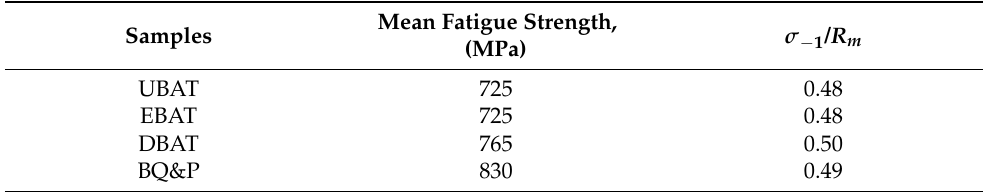
Figure 3. S-N data of steels treated by various melting and heat treatment processes; ( a ): UBAT; ( b ): EBAT; ( c ): DBAT and ( d ): BQ&P; Sur: surface-defect-induced crack initiation, Sur (Inc): surface- inclusion-induced crack initiation, Inter (Inc): interior-inclusion-induced crack initiation, NIICI: interior-noninclusion-induced crack initiation (crack initiated from microstructure). Table 2. Mean fatigue strength and σ − 1 / R m of the four bainitic steel specimens treated by different melting and heat treatment